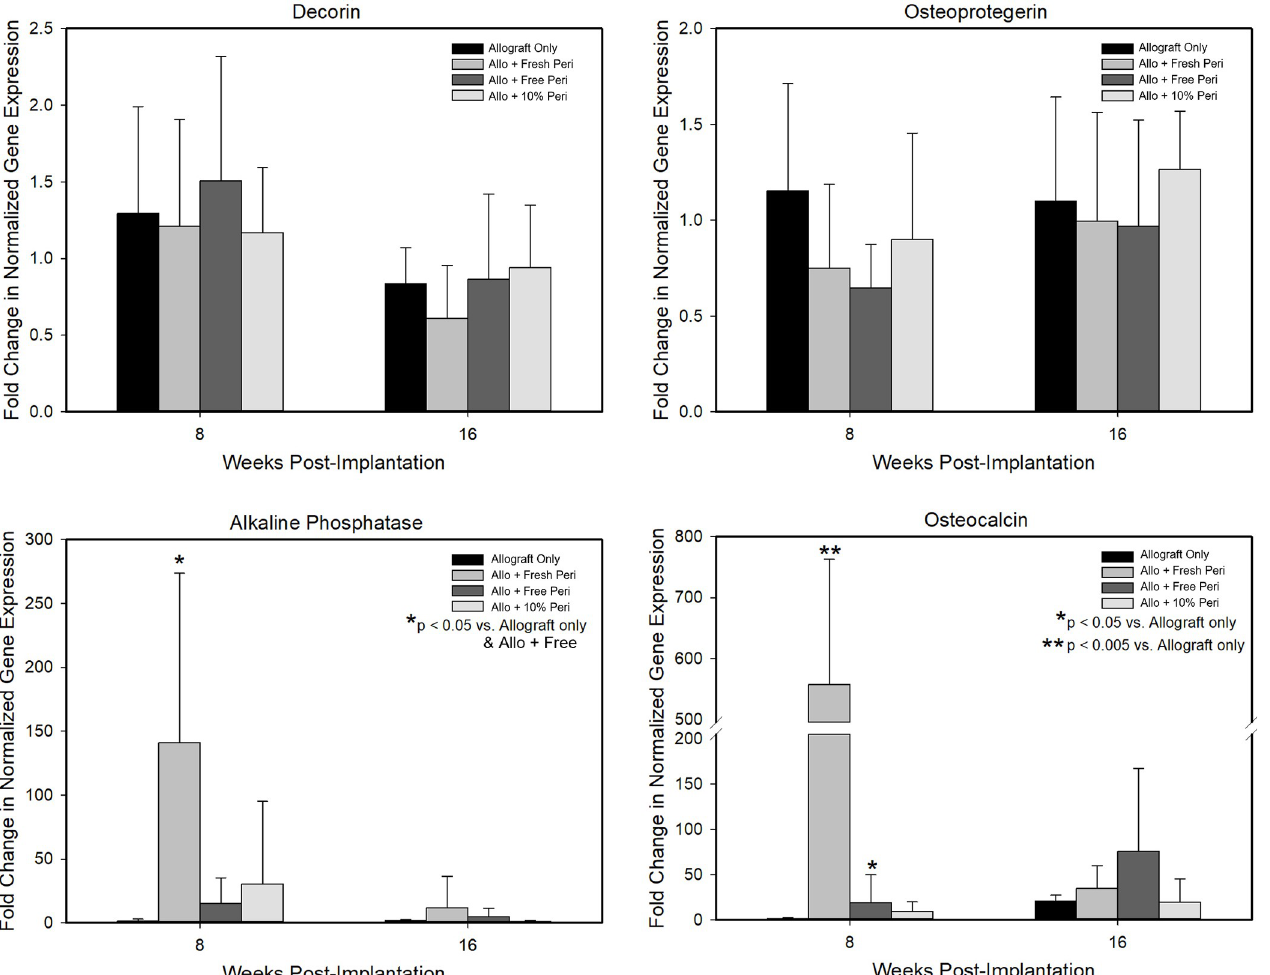
Fig 6. Expression of genes related to bone regeneration in allograft alone or wrapped with periosteum. Normalized gene expression for decorin, osteoprotegerin, alkaline phosphatase, and osteocalcin from samples collected at 8 and 16 weeks post-implantation.